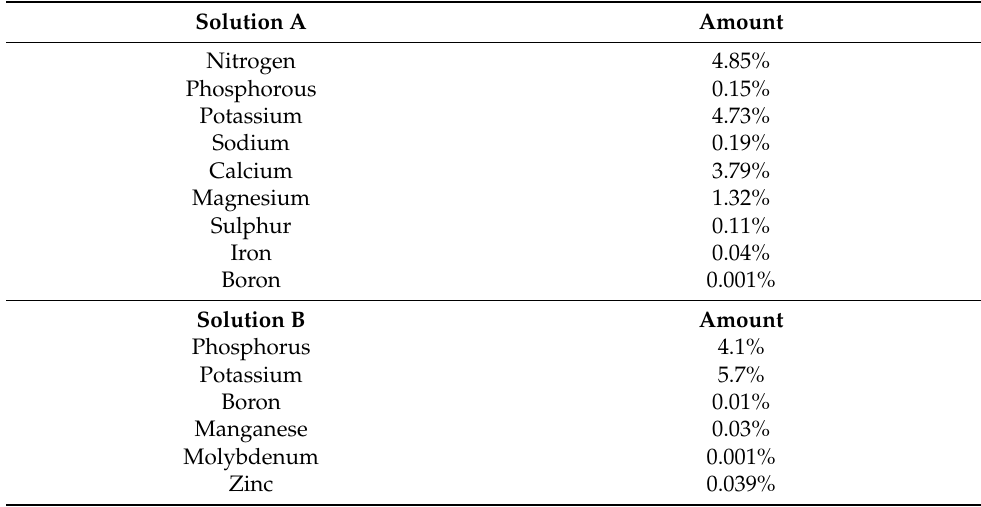
Table 2. Chemical composition of the Atami© B’Cuzz Hydro nutrient solution. Solution